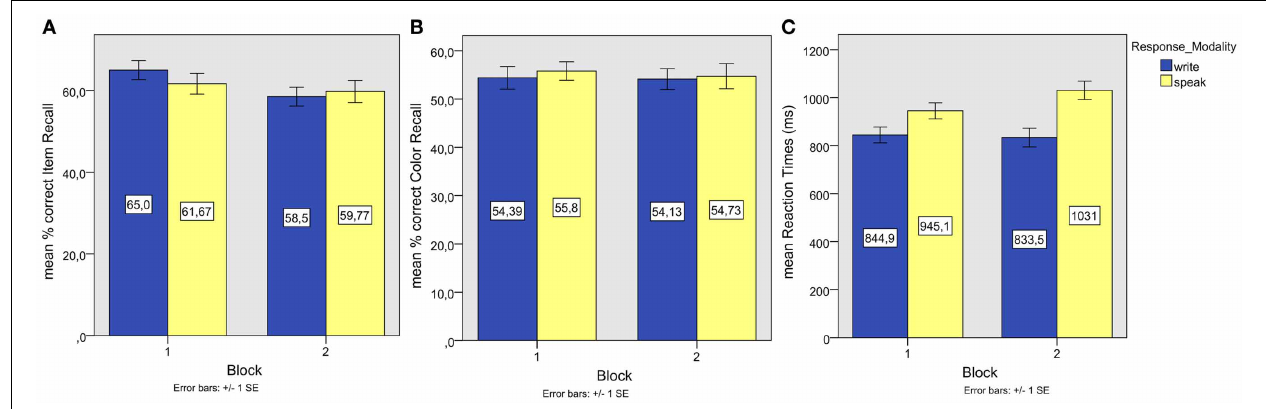
FIGURE 3 | Experiment 2. (A) Mean associate word (item) recall performance; (B) Mean episodic information (background color) recall performance; (C) Mean reaction times of correct associate word recall responses.